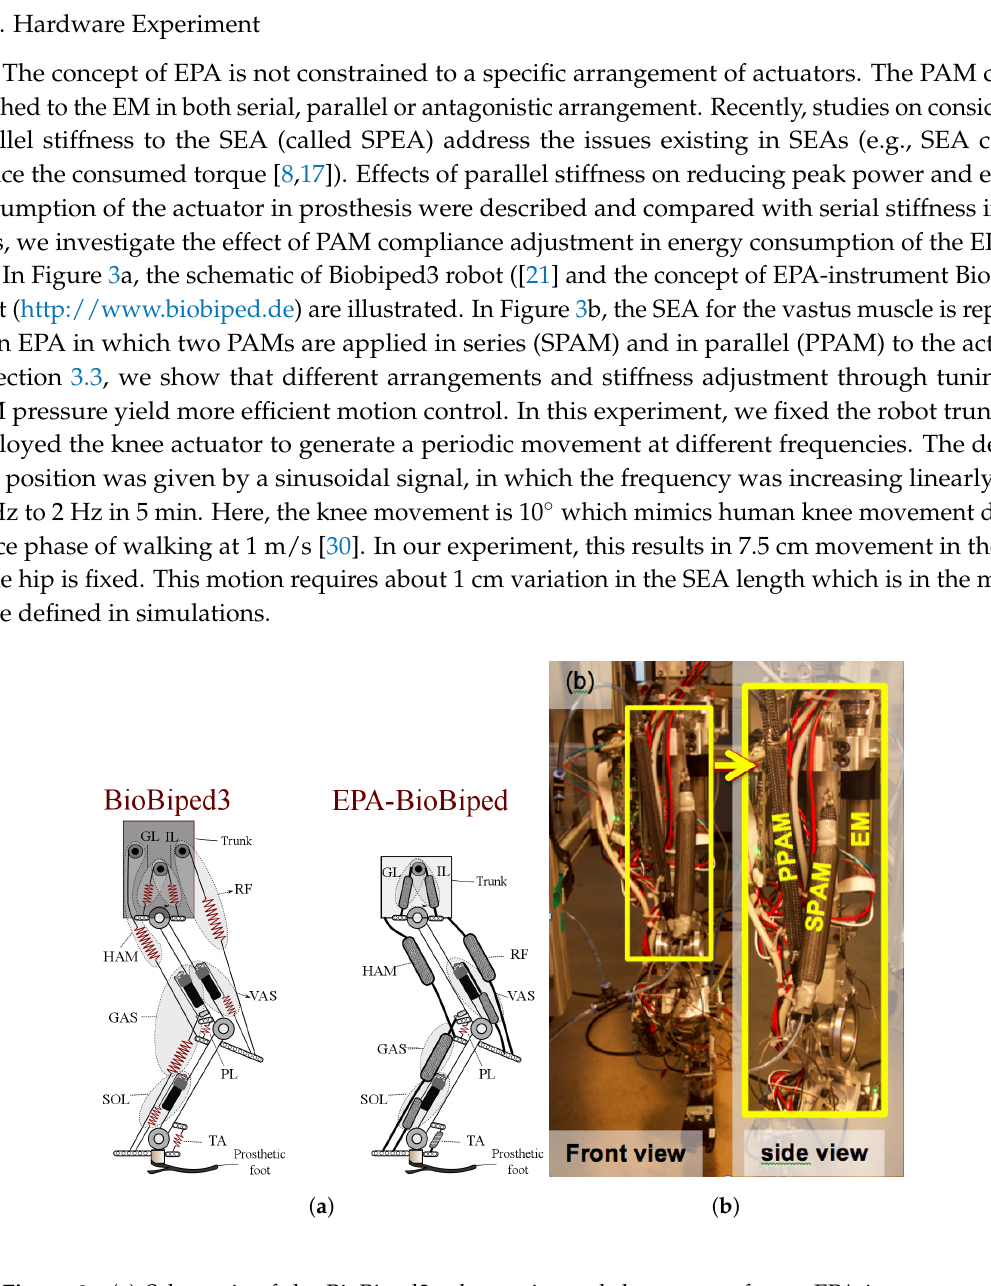
Figure 3. ( a ) Schematic of the BioBiped3 robot series and the concept for an EPA-instrumented BioBiped by replacing SEAs with EPAs and passive springs with PAMs; and ( b ) implementation of EPA in BioBiped3 representing the Vastus muscle, including one electric motor (EM), one serial (SPAM) and one parallel PAM